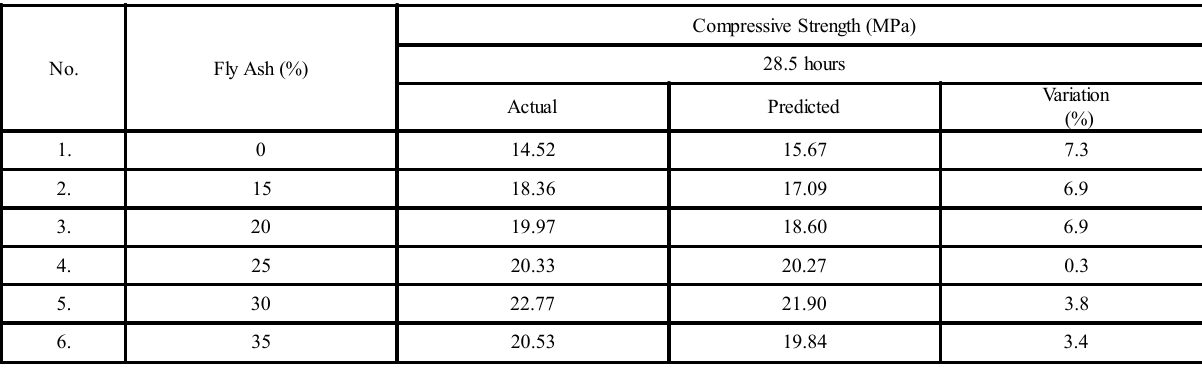
TABLE 5. PERCENTAGE VARIATION IN 28.5 HRS COMPRESSIVE